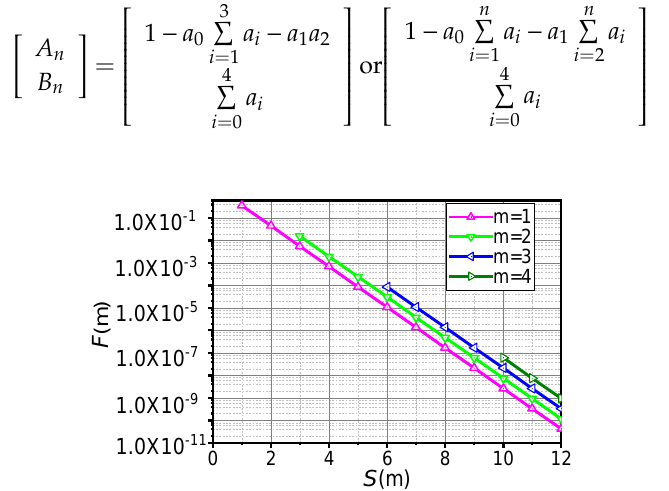
Figure 2. Decreasing of F ( m ) as m or S( m ) increases.